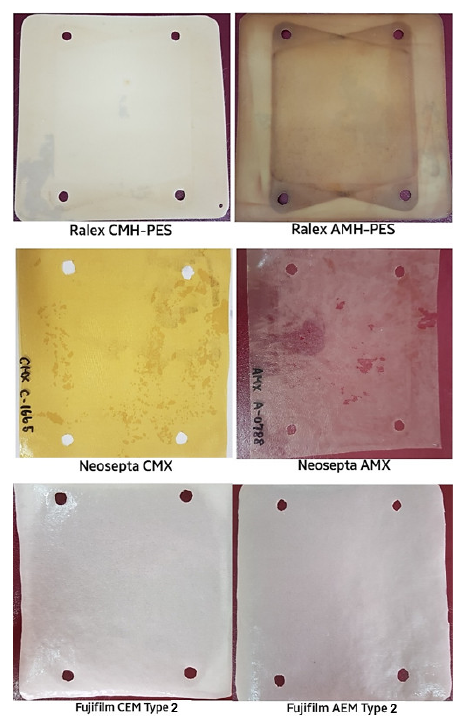
Figure 3. Images of commercial ion exchange membranes [14].